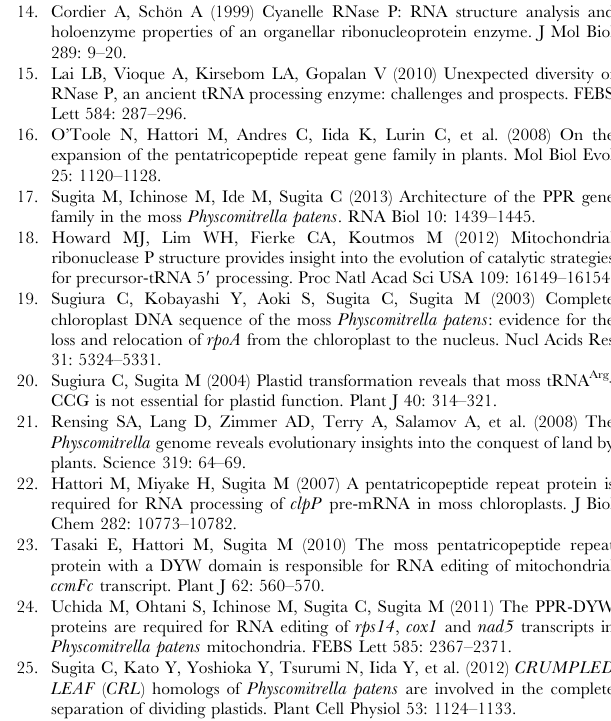
amide containing 7 M urea and transferred to nylon membranes. were labeled with DIG-ddUTP and terminal deoxynucleotidyl transferase (Roche). Figure S8 Northern blot analysis of mitochondrial tRNAs. Total cellular RNAs (5 m g) were subjected to northern blot analysis as described in Fig. S7. Mitochondrial tRNA gene- specific oligonucleotide probes (Table S2) were labeled as described in Fig. S7.